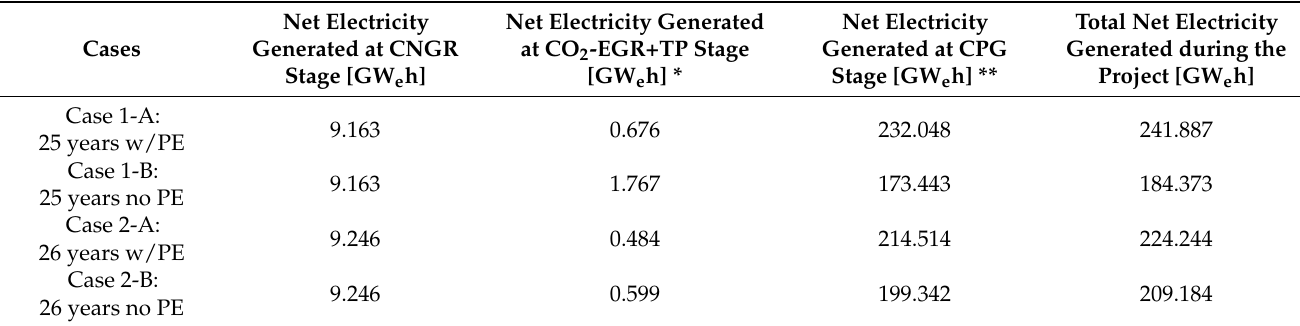
Table 4. Simulation results for the net geothermal electricity generation performance metrics during the four stages of the combined CO 2 -EGR–CPG system, calculated for the four cases (considering residual methane content and the PE